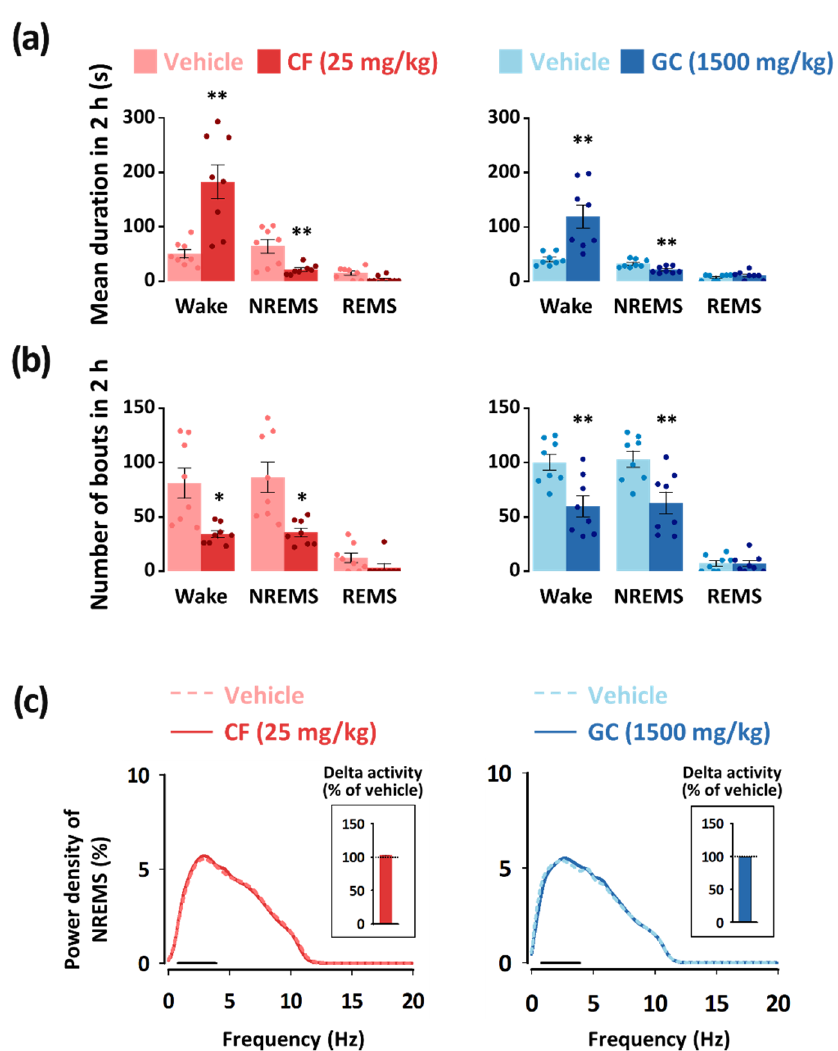
Figure 5. Characteristics of sleep–wake bouts in C57BL/6N mice during the 2 h period after administration of caffeine (25 mg/kg) and GC (1500 mg/kg). ( a ) Changes in the mean duration of wakefulness, NREMS, and REMS bouts. ( b ) Changes in the total number of wakefulness, NREMS, and REMS bouts. ( c ) EEG power density curves during NREMS. Light color bars indicate the baseline day (vehicle). Delta activity, an indicator of sleep intensity, is shown in the inset histogram. The solid bar (—) represents the range of the delta wave (0.5–4 Hz). Each value represents the mean ± SEM of each group. ( n = 7–8). * p < 0.05, ** p < 0.01, significantly different from vehicle (unpaired